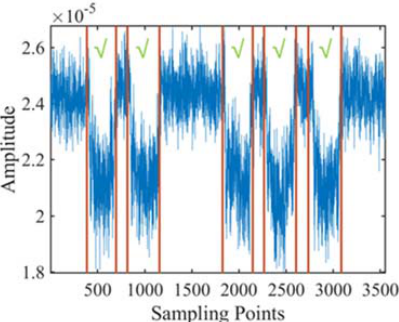
Figure 16. Segmentation example of the received amplitude sequence during five squats. Green check labels each squat segment. The red vertical lines label the start and end timestamp of each squat.